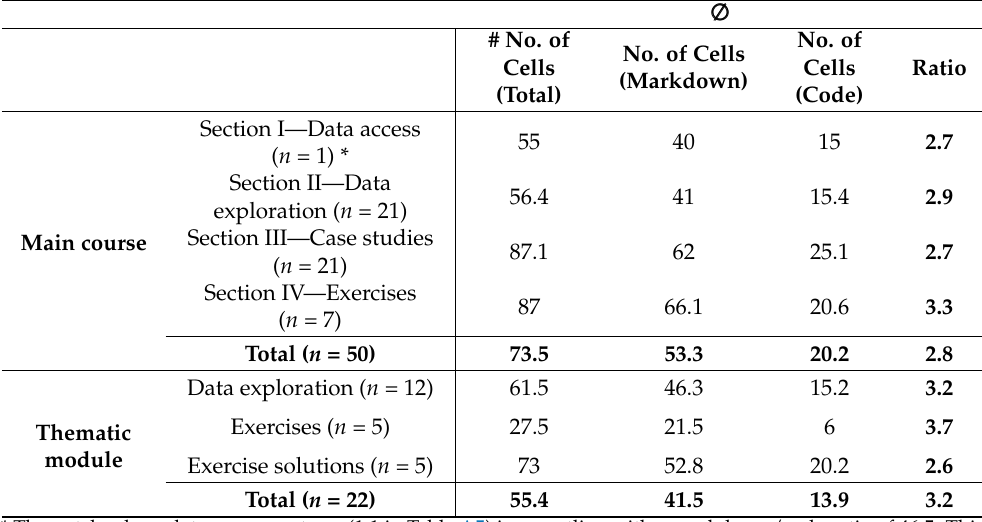
Table 3. Average number of total, markdown and code cells for each category of the LTPy main course and of the thematic module. Each entry summarized from Appendix A Tables A5 and